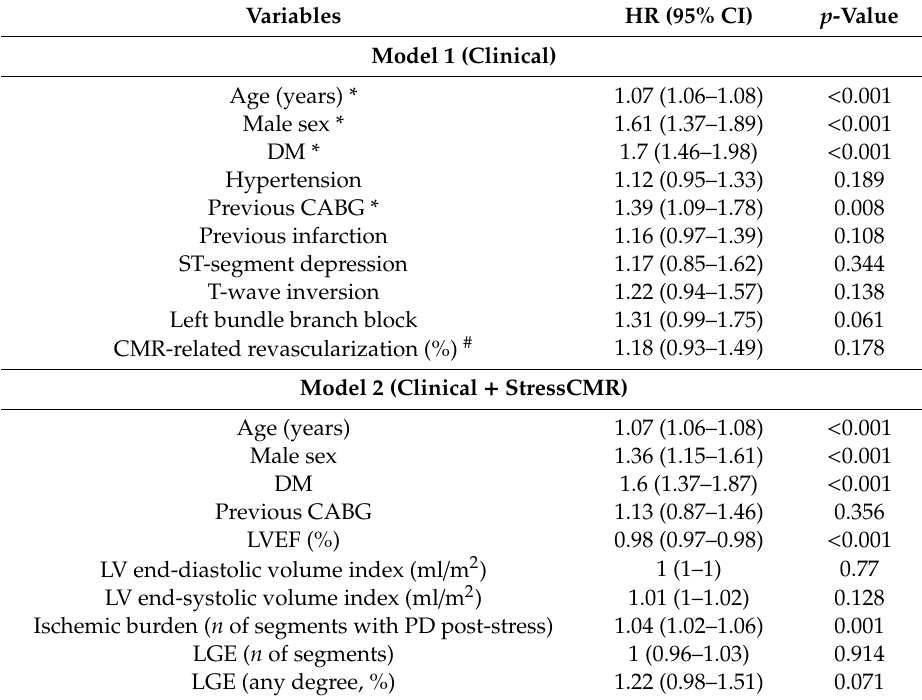
Table 3. Multivariable Cox regression analysis for the all-cause mortality